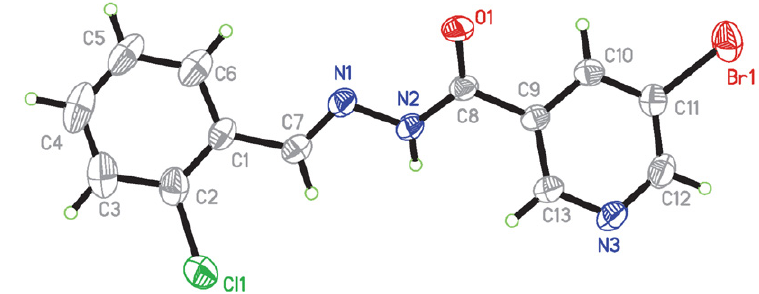
Figure 1. Molecular structure of 1 at 30% probability displacement. Only the major component of the disordered group is shown.